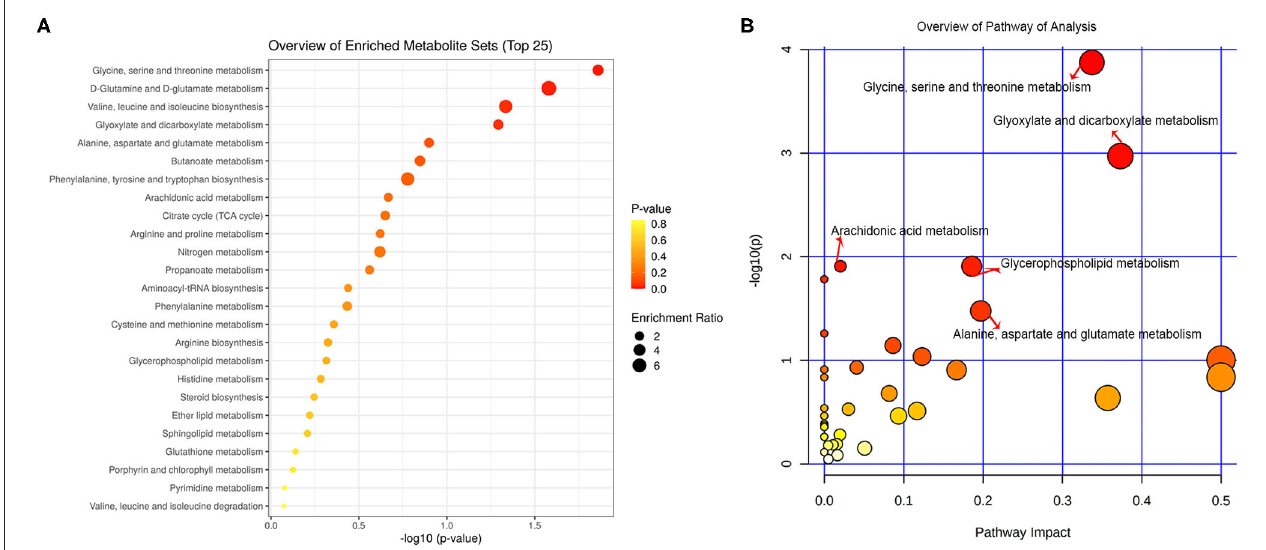
FIGURE 3 | Functional and pathway analysis of differential serum metabolites. Pathway enrichment (A) and pathway analysis (B) of differential metabolites using MetaboAnalyst 5.0. The x axis (pathway impact values) and y axis [the –log10 ( p value)] represent the influencing factor of a topological analysis and the p value of the pathway enrichment analysis. The size of the nodes reveals the influence factor of a topological analysis, whereas the color of the nodes indicates the p value of the enrichment analysis. The vital metabolic pathways were defined as having p < 0.05 and impact value > 0.